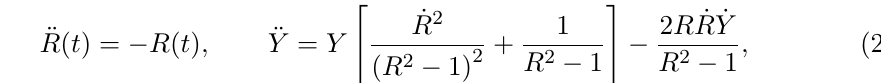
Figure 3. Illustration of the (future half of the) WDW patch in defect AdS the two half cones, already present for the case of vacuum AdS 3 . S L boundaries of the WDW patch in the defect region, (cid:12)xed by parts of the lightcones generated from the points (cid:18) = 0 ; (cid:25) on the boundary ( (cid:30) = (cid:25)= 2). Those null surfaces are smoothly connected (cid:6) across the defect and they terminate along a ridge at the top of the WDW patch. The yellow surfaces correspond to the defect brane, where the left and right patches are glued